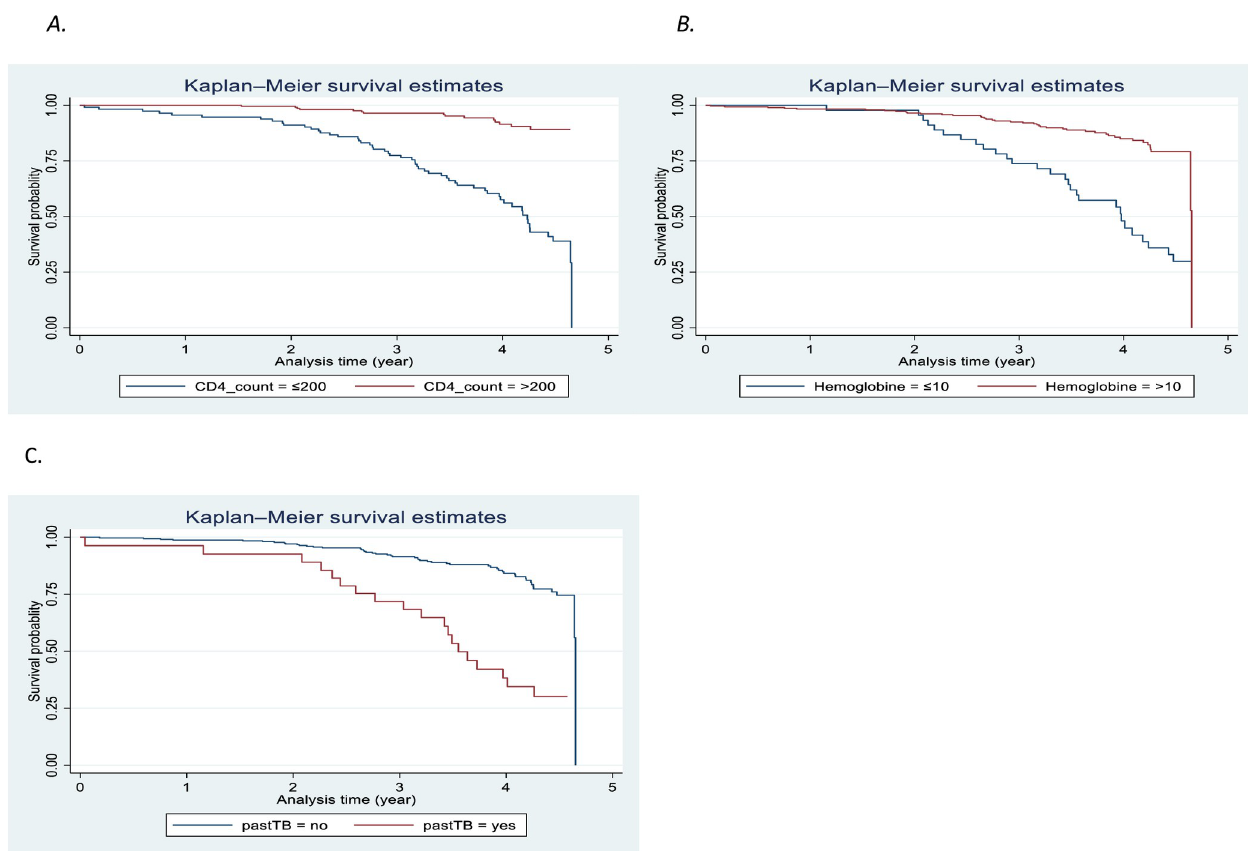
Fig 2. Non-parametric estimates of cumulative survival curves across categories of CD4 count (A), Hemoglobin (B) and Past history of TB (C).